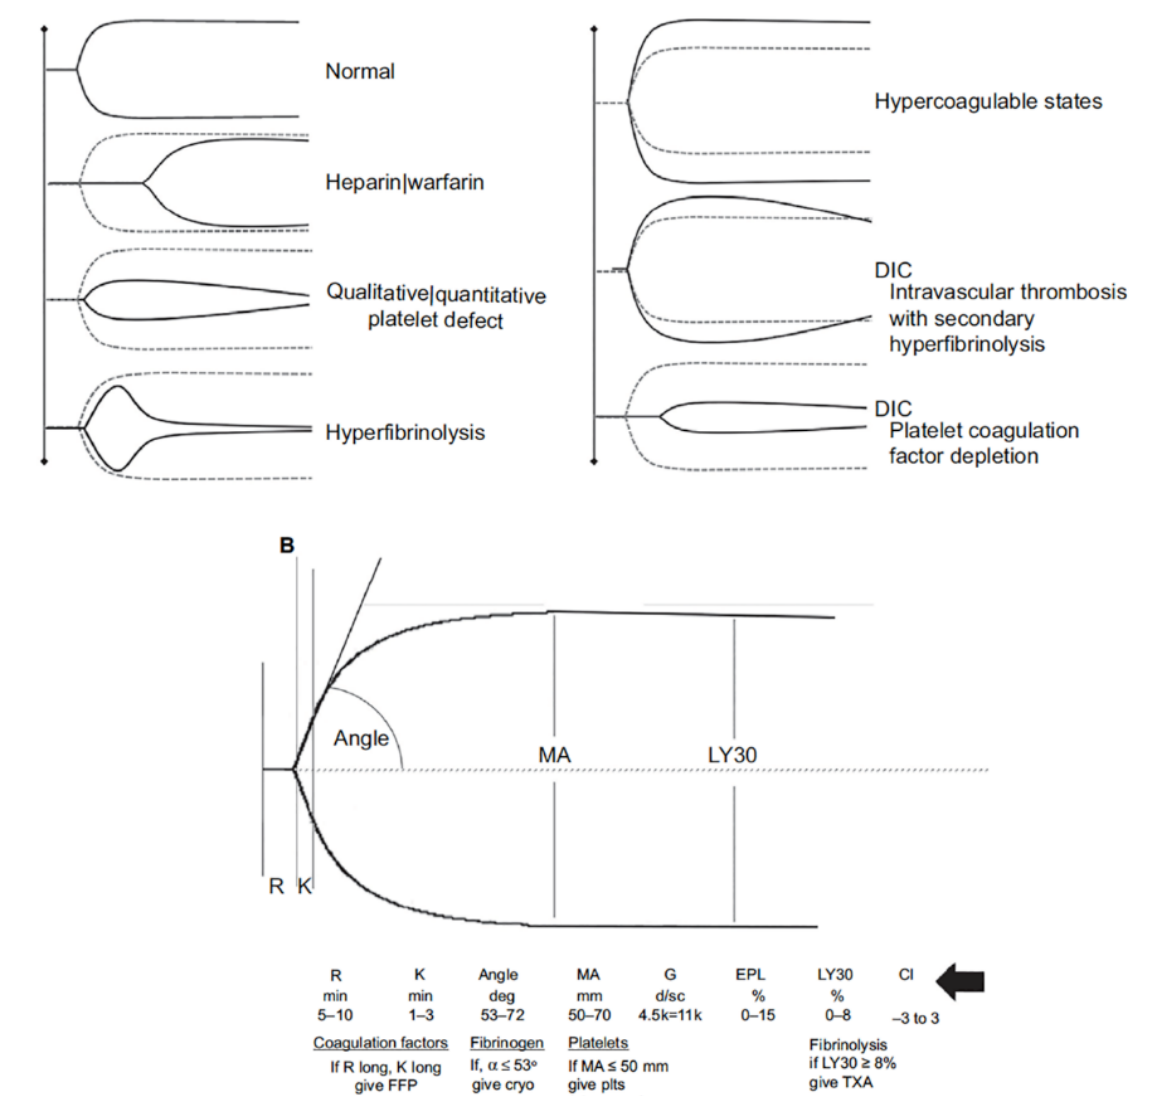
Figure 4. Thromboelastography (TEG ® ). ( A ) Schematic presentation of different viscoelastic tracings reflecting states of the coagulation system compared with normal. ( B ) Basic viscoelastic tracing with measured parameters and limits of normal for thromboelastography, correlated with different elements of the coagulation system (R = reaction time, K = clot formation time, angle, MA = maximum amplitude, Ly30 = percent clot lysis 30 m after MA). Viscoelastic k-time and angle correlate to some degree with fibrinogen concentration. However, the agreement between these parameters and fibrinogen levels determined by standard von Clauss assay is not sufficiently strong to be useful clinically. To overcome this limitation with TEG, the specific contributions of fibrinogen and platelets to clot strength can be determined with additional reagents (TEG; Functional Fibrinogen [Haemonetics Corp, Niles, IL, USA]). Using TEG, additional measures of clot strength can be computed. Coagulation index (CI; black arrow) is derived from R, k-time, angle, and MA, with a CI >+3.0 suggesting a hypercoagulable state and CI < − 3.0 suggesting coagulopathy. The shear elastic module strength, designated G, is a computer-generated quantity that reflects an integrated measure of clot strength. Conceptually, G is considered the most informative parameter of clot strength because it reflects the contributions of the enzymatic and platelet components of hemostasis. Abbreviations: rTEG, rapid thromboelastography; DIC, disseminated intravascular coagulation; EPL, estimated percent lysis; FFP, fresh frozen plasma; Cryo, cryoprecipitate; Plts, platelets; TXA, tranexamic acid. Viscoelastic assays such as TEG that are used to diagnose hyperfibrinolysis may take as long as 60 min before results are obtained on which to base anti-fibrinolytic therapy with TXA. Delays in TXA administration to trauma patients who are coagulopathic due